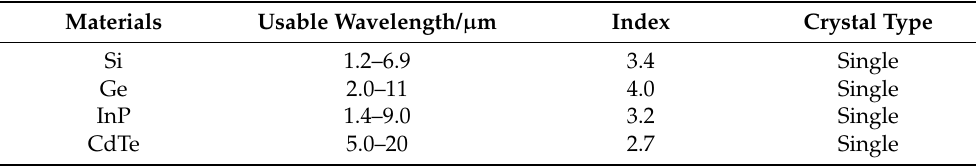
Table 1. Optical properties of candidate materials for IR immersion gratings.